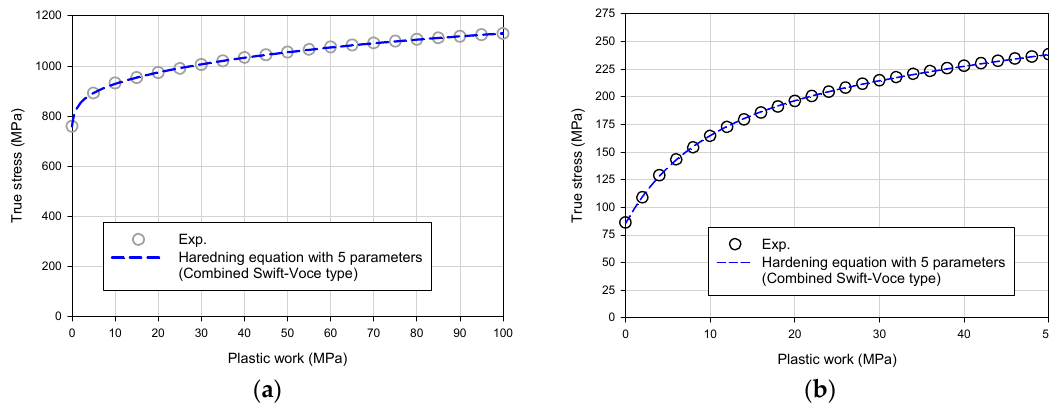
Figure 11. Comparison of the measured and calculated hardening behavior of ( a ) the QP980 steel and ( b ) niobium sheet with respect to the plastic work.